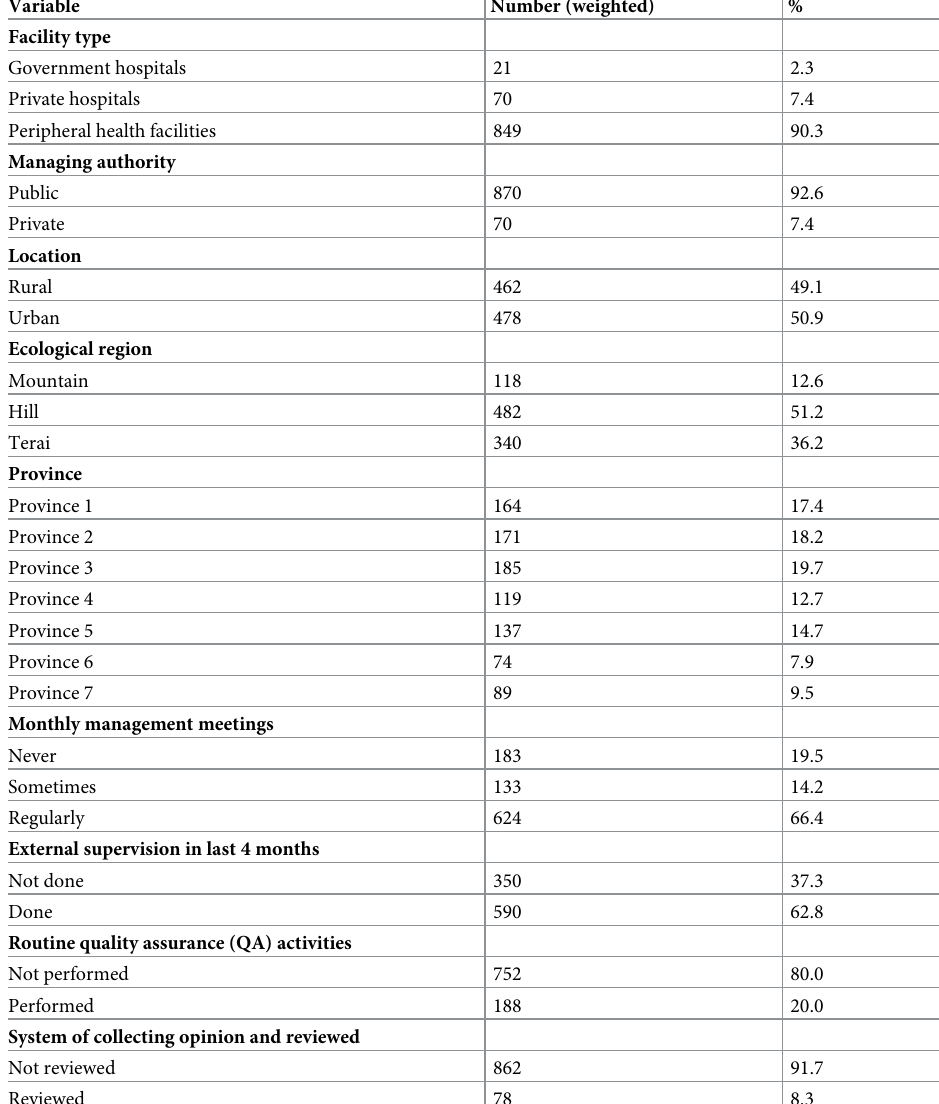
Table 1. Percentage distribution of surveyed facilities (excluding standalone HTCs) according to background characteristics (n =